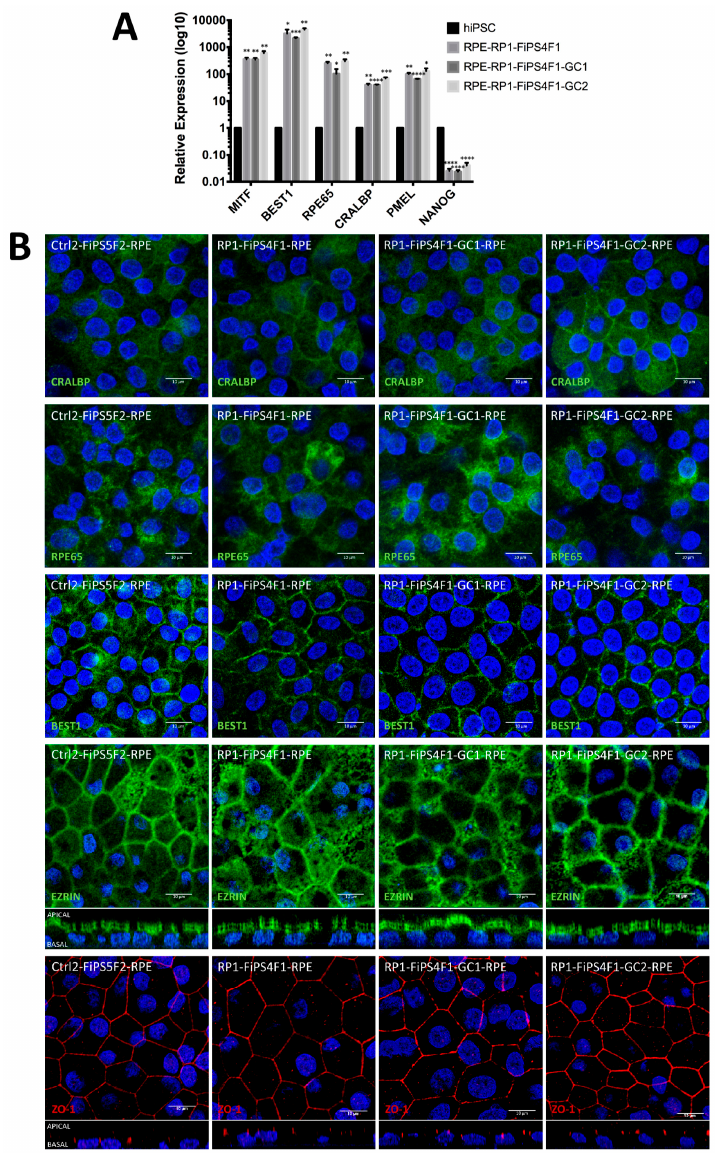
Figure 2. RPE-associated gene and protein expression in hiPSC-RPE. ( A ) qRT-PCR analysis of mRNA expression for RPE markers ( MITF , BESTROPHIN ( BEST1) , RPE65 , CRALBP , and PMEL ) and pluripotency marker NANOG . Data represent fold-change in mRNA expression of three hiPSC-RPE lines relative to their hiPSC. Each bar represents the average ± SEM of at least three independent biological replicates. The differences in mRNA expression between the hiPSC-RPE and their originating hiPSC were tested for significance (* p ≤ 0.05, ** p ≤ 0.01, *** p ≤ 0.001, **** p ≤ 0.0001). ( B ) Immunocytochemistry analysis of protein expression for RPE markers (CRALBP, RPE65, BEST1, EZRIN, and Zonula Occludens protein-1 (ZO-1)) in hiPSC-RPE. Representative confocal z-stacks micrographs of polarized RPE for apical expression of EZRIN and apico-lateral expression of ZO-1. Images were taken with Leica confocal microscope TCS SP8 (Wetzlar, Germany) using HCX PL APO lambda blue 63X/ 1.4 oil objective. Scale bar 10 µ